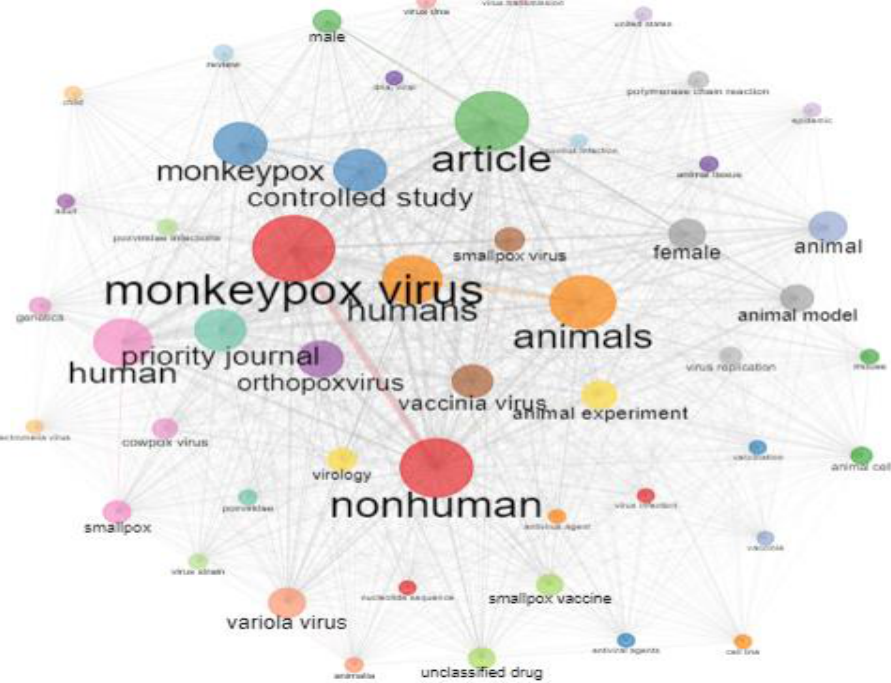
Figure 2. Co-occurrence network visualization for MPV research: keywords .